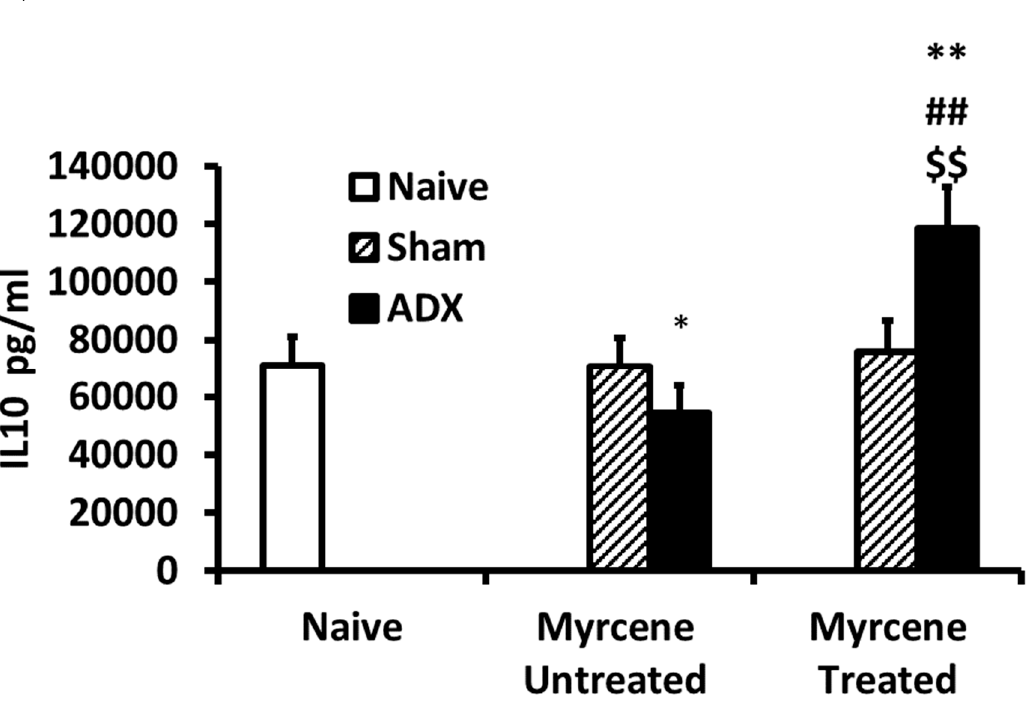
Figure 2. Immune modulatory and anti-inflammatory cytokines levels in ADX, sham operated, and myrcene treated ADX and sham operated rats: IFN- γ ( A ); IL-4 ( B ); and IL-10 ( C ). In the untreated ADX group, IFN- γ and IL-4 were upregulated significantly compared to sham operated group. Myrcene did not decrease IFN γ , while significantly decreased IL-4 compared to the untreated ADX. In the untreated ADX group, IL-10 concentration was significantly lower than sham controls, while myrcene treatment significantly upregulated IL-10 compared to the untreated ADX group. * p < 0.05, ** p < 0.01, *** p < 0.001, compared to naïve; ## p < 0.01 ### p < 0.001 compared to untreated sham; $$ p < 0.01, $$$ p < 0.001 compared to untreated ADX.